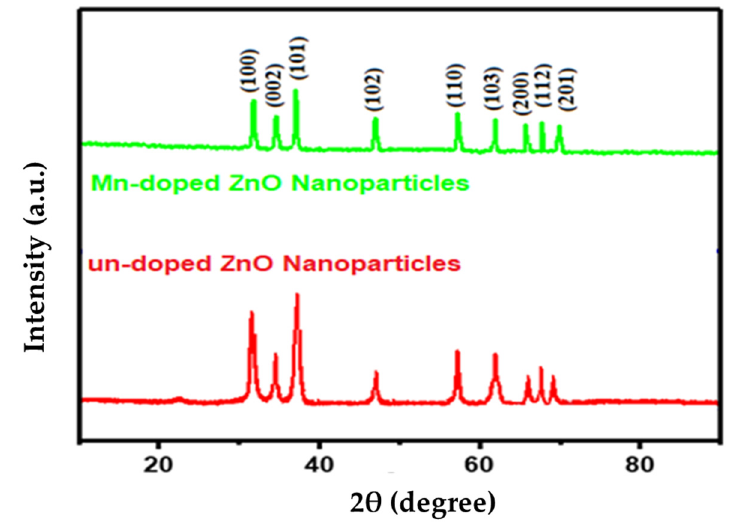
Figure 1. XRD pattern of ZnO and Mn-doped ZnO nanoparticles.